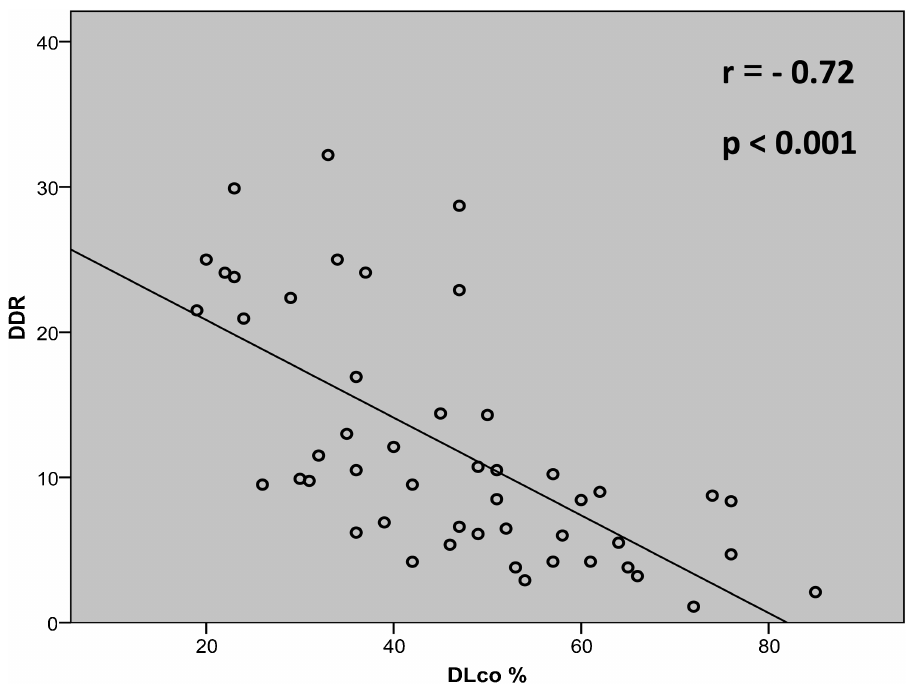
Figure 2 - Correlation between DLco% and DDR in ILD patients.